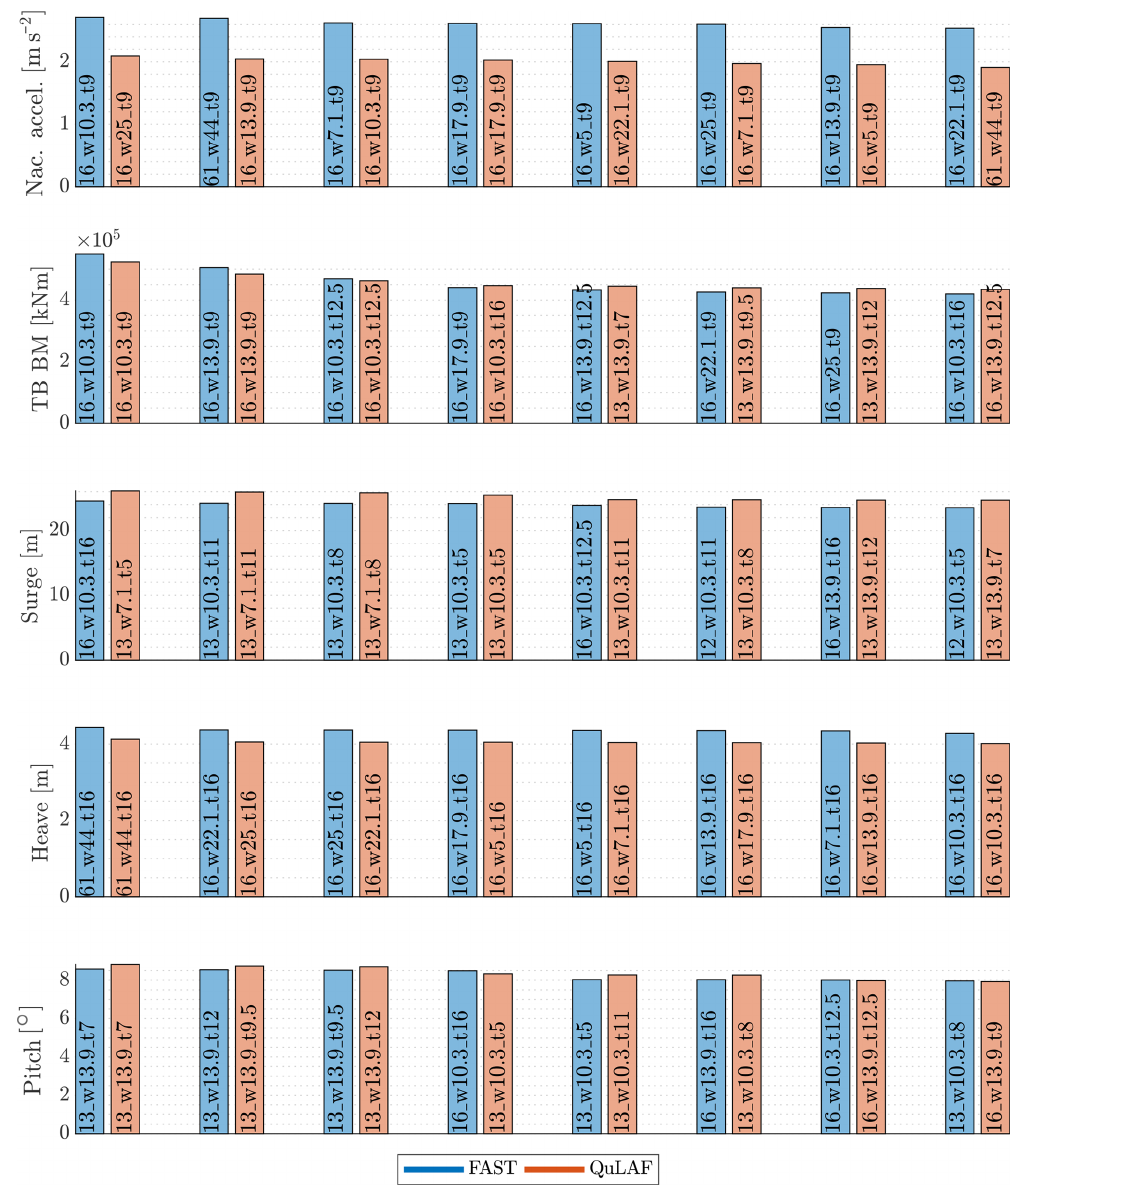
Figure 10. Rankings of the eight highest max. values of each signal and corresponding load case simulations for FAST and QuLAF. The text in each box follows the pattern of design load case, mean wind speed and then wave period, i.e. dlc _ wsp _ tp